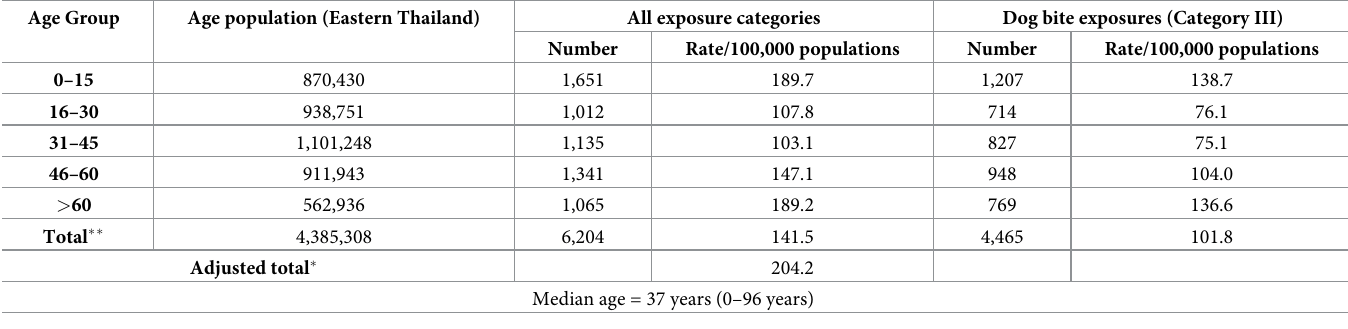
Table 4. Suspected rabies exposures and dog bites reported through R36 surveillance system by age group, 1 st Jan– 31 st Dec